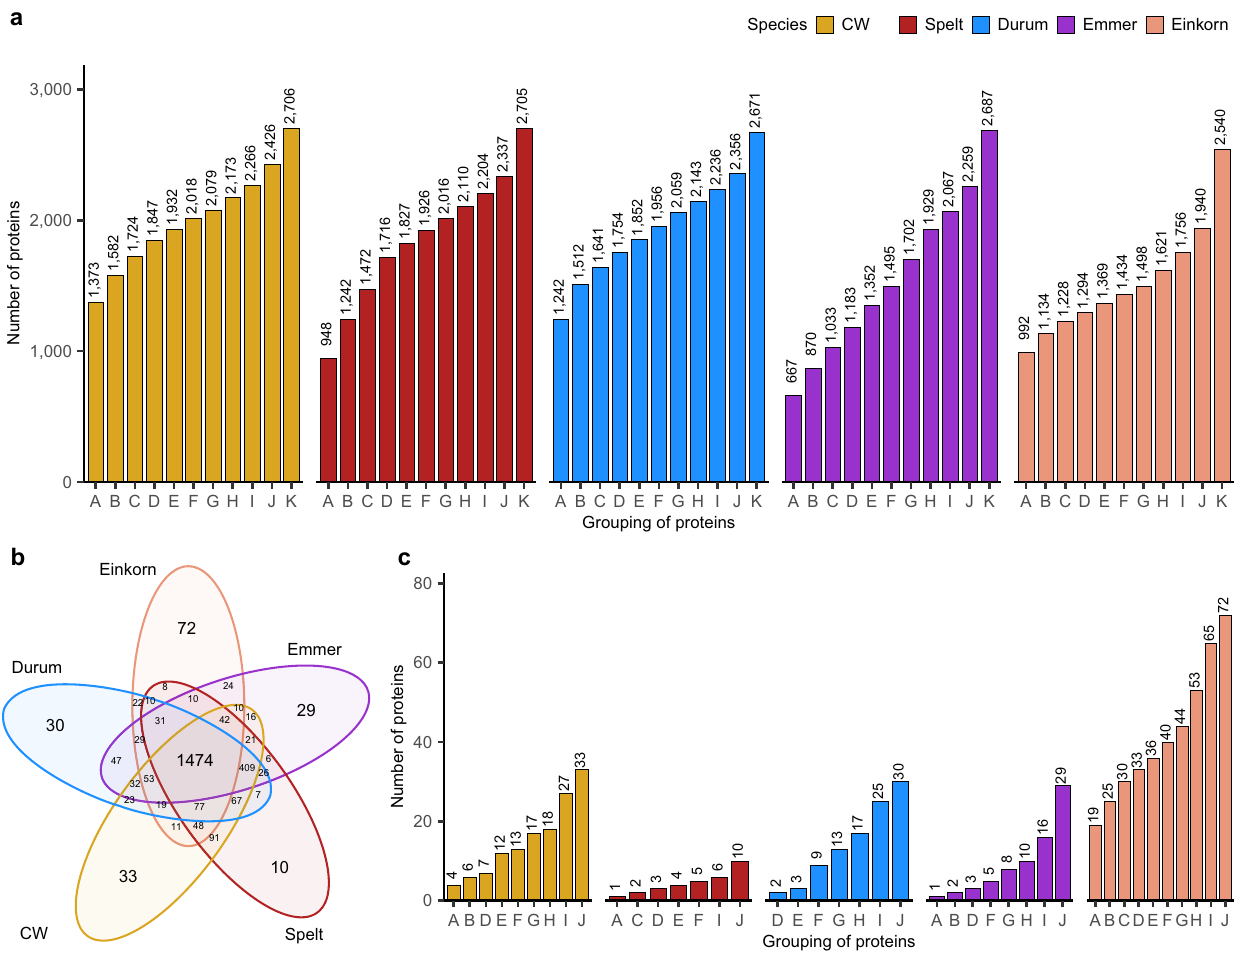
Fig. 1 Overview of the identi fi ed proteins in fi ve wheat species. a Grouping of proteins based on their presence in a certain number of cultivars across three environments. The capital letters on the x-axis denote groups of proteins. These groups correspond to the proteins that were expressed in all of the three environments in all 10 cultivars (A), in at least 9 (B), 8 (C), 7 (D), 6 (E), 5 (F), 4 (G), 3 (H), 2 (I) cultivars and in at least 1 (J) cultivar. Proteins belonging to group K were found in at least one sample. For further analysis, the proteins from group J were considered. b Number of proteins that are unique or common between species. c Grouping of the unique proteins (from Fig. 1b) based on their presence in a certain number of cultivars across three environments. The letters on x-axis have the same denotation as in Fig. 1a. CW, common